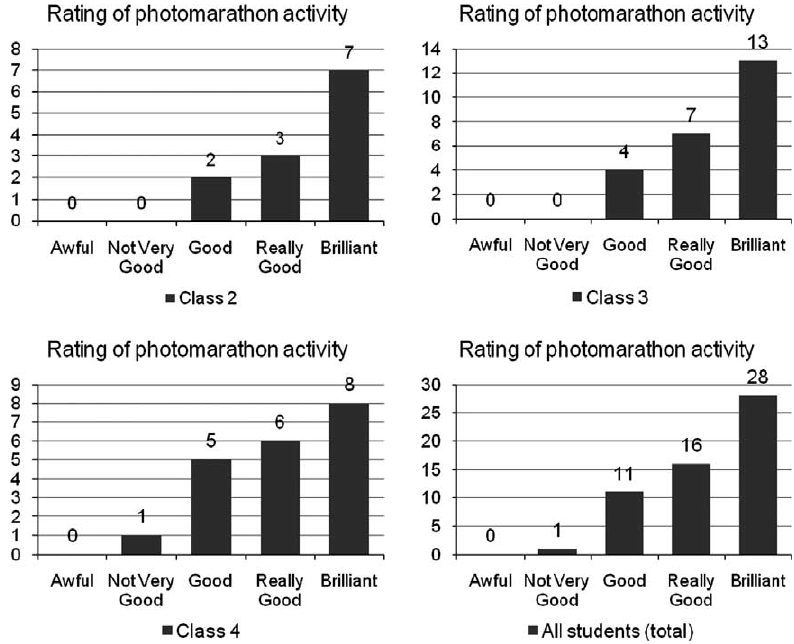
Figure 4. The students’ ratings of the photomarathon activity, for each class and total.